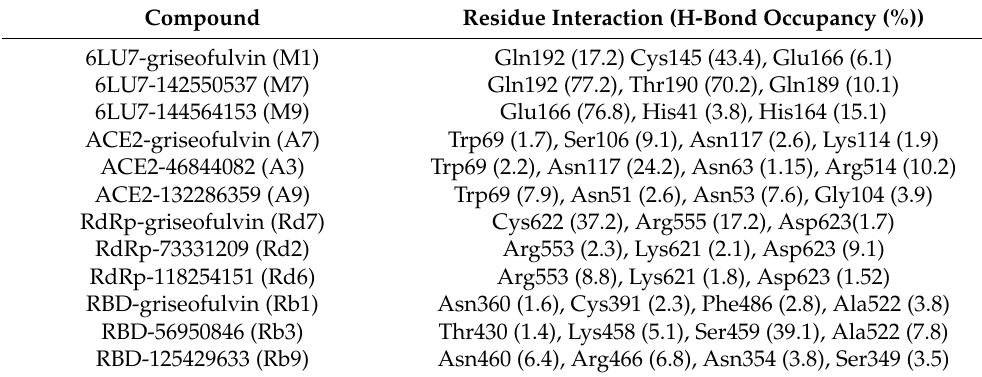
Table 6. The residue interaction and hydrogen bond (H bond) percentage occupancy from the simulation